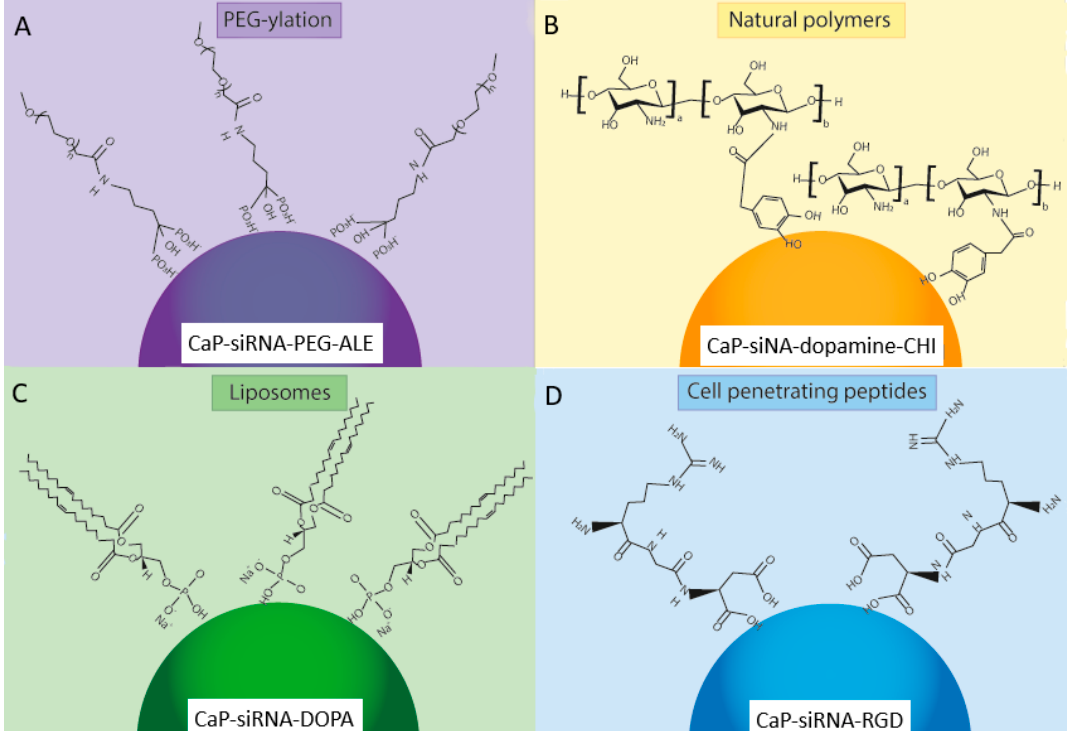
Figure 3. The main methods for surface functionalization of CaP nanoparticles loaded with genetic material (RNAi): ( A ) PEG-ylation, ( B ) Natural polymers, ( C ) Liposomes, ( D ) Cell penetrating peptides. One example of each surface functionalization method is shown. PEG-ylation using PEG and alendronate (PEG-ALE) is shown in ( A ) [155], the natural polymers chitosan and dopamine (-CHI) are shown in ( B ) [156], the use of the liposome 1,2-Dioleoyl-sn-glycero-3-phosphate (DOPA) lipid is shown in ( C ) [157], and the cell penetrating peptide Arginine-Glycine-Aspartic acid (RGD) is shown in ( D ) [74].